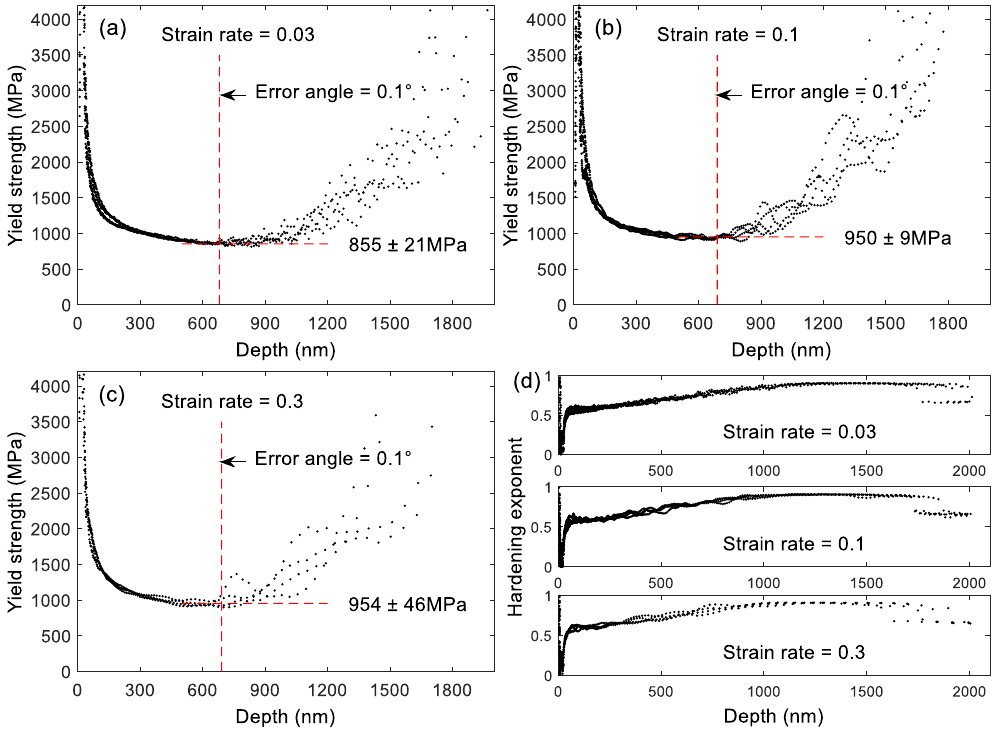
Figure 8. Variation of the yield strength and hardening exponent with depth, Ma model for three strain rates, ( a ) 0.03 s −1 ; ( b ) 0.1 s −1 ; ( c ) 0. 3 s −1 ; ( d ) the hardening exponent under three strain rates.